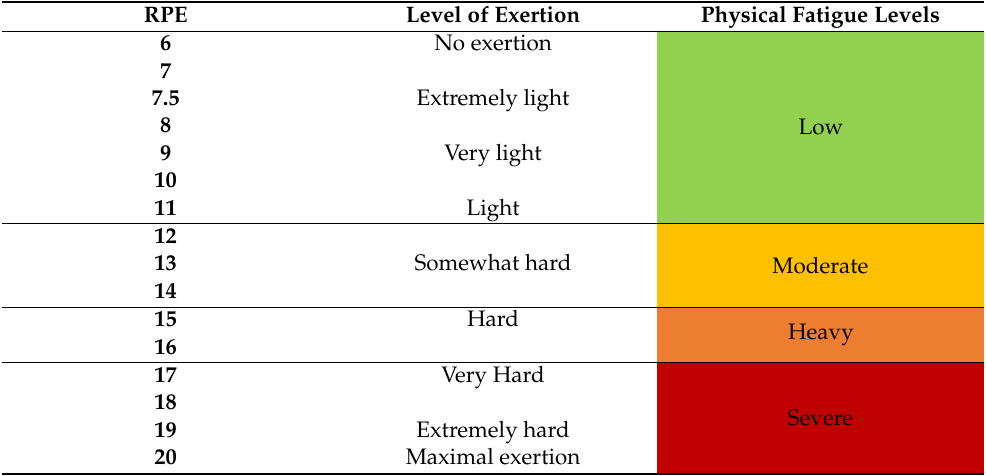
Table 1. Correspondence of the 6–20 Borg scale with the simplified 4-level physical fatigue scale. RPE Level of Exertion Physical Fatigue